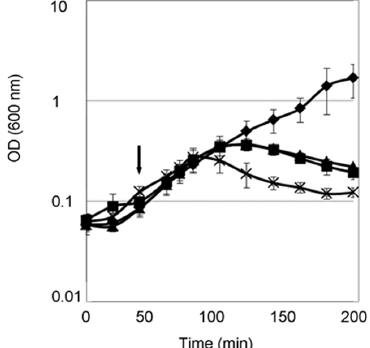
Figure 2. Effects of the periplasmic expression of PcaM1 variants on the growth of E. coli . FB8 cells were grown at 37 °C in 2YT medium and the expression of the PcaM1 variants was induced by the addition of anhydrotetracycline (arrow). Growth curves observed for the FB8 strain carrying the pASK ‐ IBA4 empty vector or pASK plasmids expressing the wild ‐ type PcaM1, the D222A mutant or the isolated activity domain ( Δ 1 ‐ 107 PcaM1) are shown by diamonds, squares, triangles and crosses, respectively. Four independent experiments were performed for each strain.